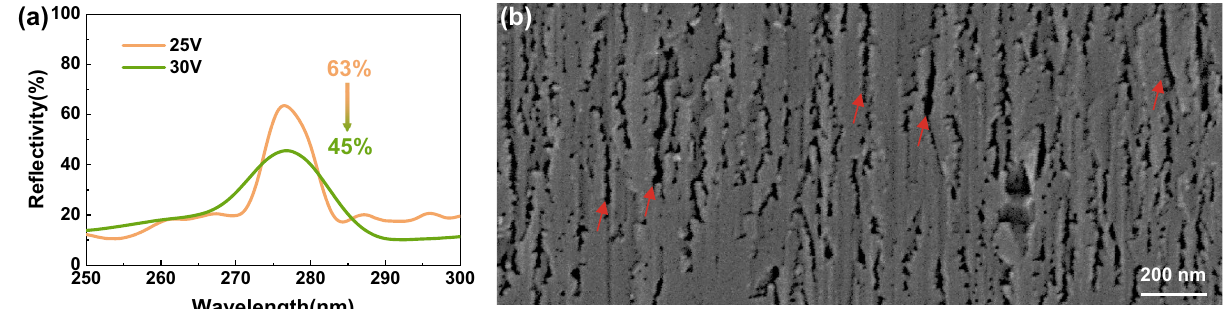
Figure 5. ( a ) The reflectivity spectra of DBRs prepared at 25 V or 30 V in KOH solution at 25 °C; ( b ) Cross- sectional SEM images of the DBRs etched at 30 V and 25